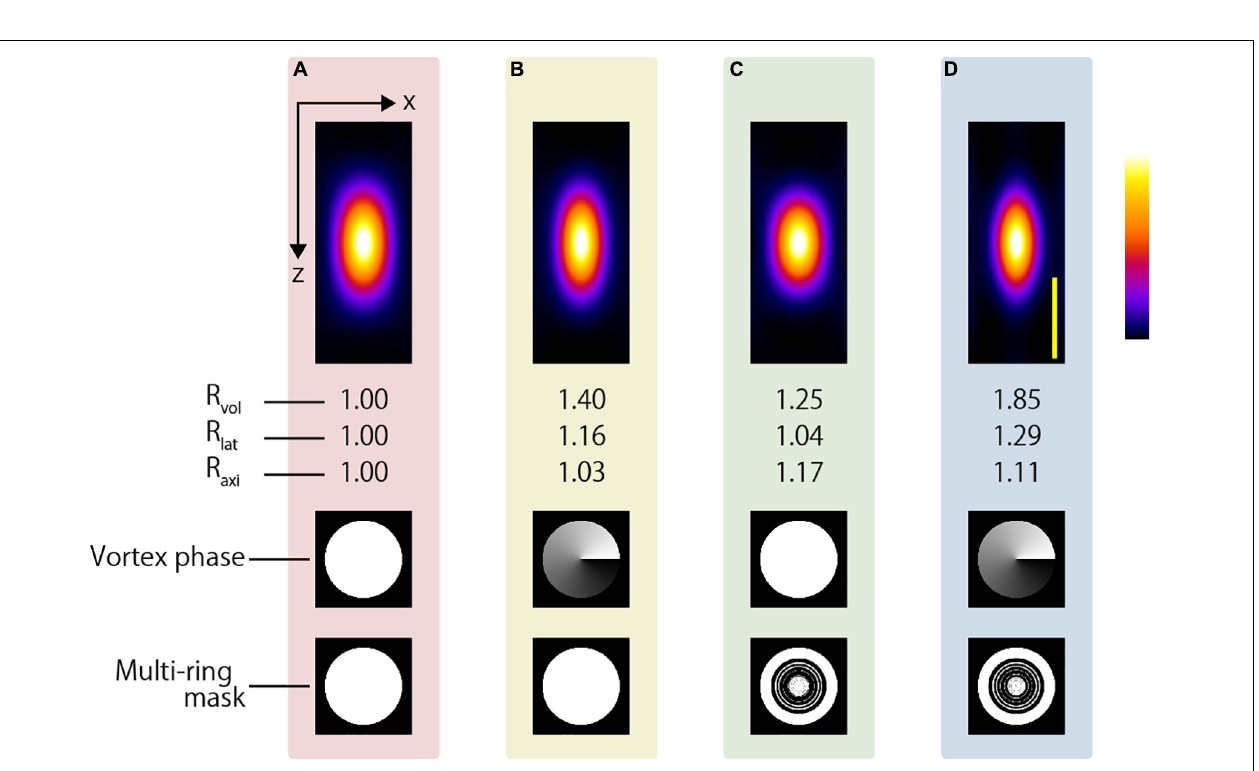
FIGURE 11 | Simulation results of two-photon PSFs when the oil immersion objective lens with NA = 1.49 is used to focus using the (A) CP, (B) APV, (C) AMCP, and (D) AMAPV excitation beams. Top: the x-z projected images of the two-photon PSFs. Middle row: phase patterns for realizing the first resolution-enhancement method. Bottom: eight-ring mask pattern for realizing the second resolution-enhancement method. Scale bar: 500 nm.